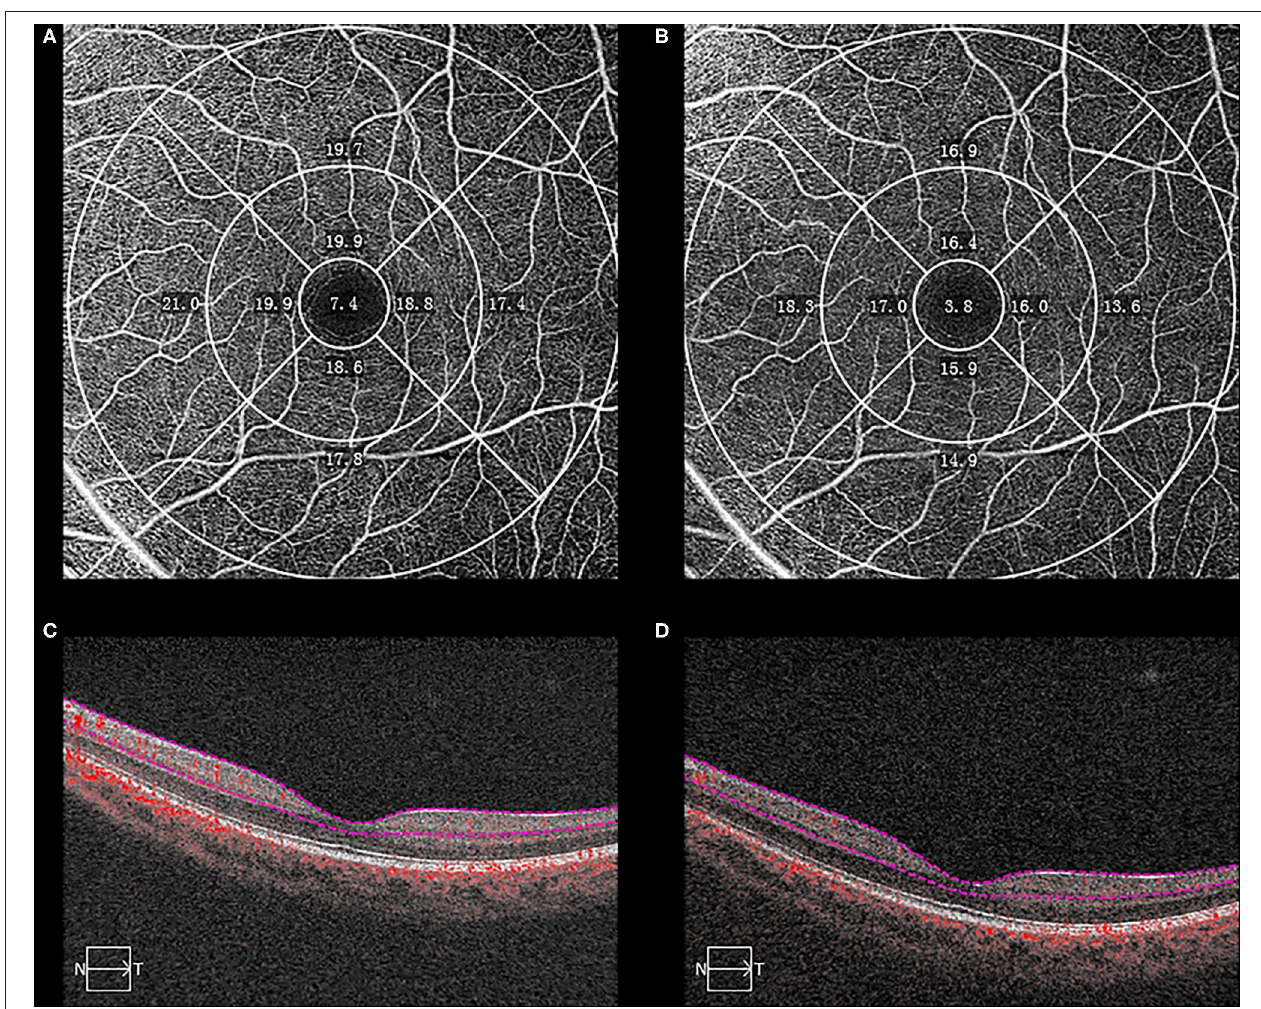
FIGURE 1 | Optical coherence tomography angiographic (OCTA) images from a 18-year-old student with myopia who was followed-up from October 2016 to July 2018. The macular vessel density (VD) decreased between baseline (A) and the end of follow-up (B) in each sector. The boundaries used for segmentation were indicated between two red lines on the cross-sectional OCTA reflectance (C,D) . The sectors were automatically measured according to the Early Treatment of Diabetic Retinopathy Study